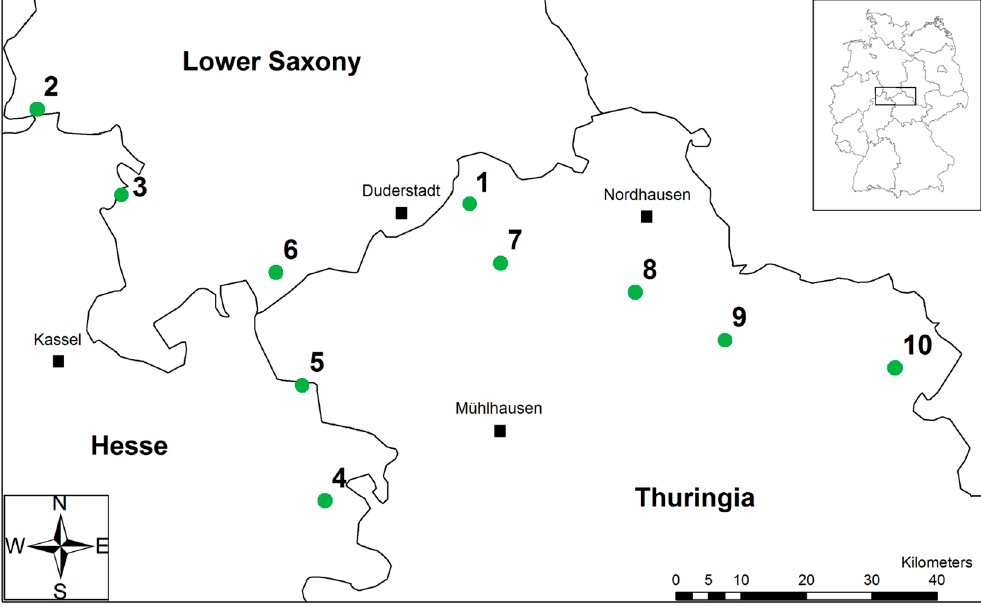
Figure 1. Study region in Thuringia, Lower Saxony, and Hesse with ten forest sites (green circles). Forest sites: ( 1 ) Winkelberg; ( 2 ) Tiefentals Ebene; ( 3 ) Klingenberg/Vaaker Berg; ( 4 ) Schieferstein; ( 5 ) Heiligenberg; ( 6 ) Bocksbühl; ( 7 ) Hubenberg; ( 8 ) Feuerkuppe; ( 9 ) Heidelberg; and ( 10 ) Eichleite. Original copyright: GeoBasis-DE/BKG 2015, data changed with permission from Bundesamt für